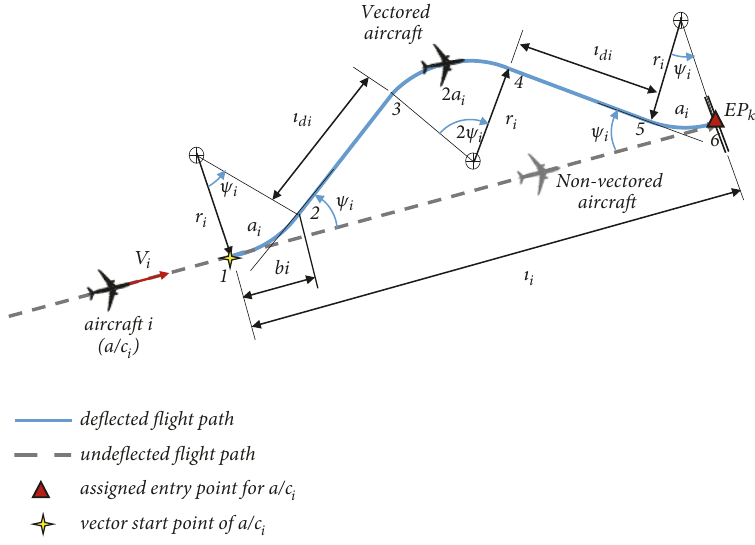
Figure 4: Vector deflection maneuver.